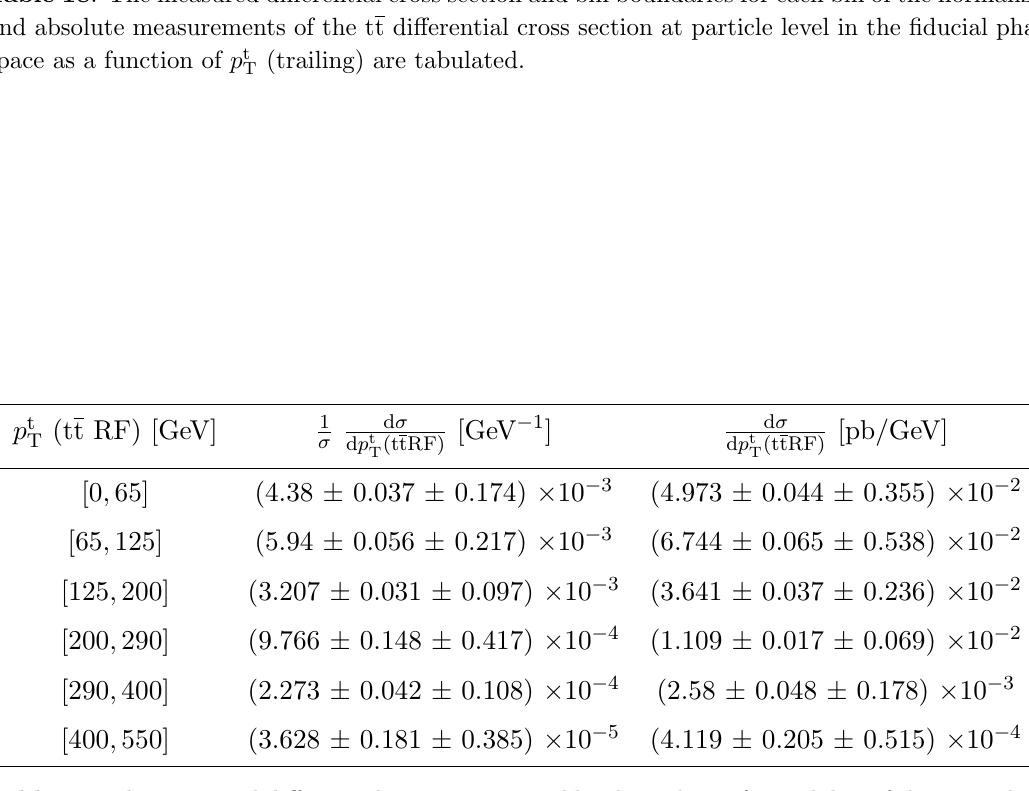
Table 19 . The measured di(cid:11)erential cross section and bin boundaries for each bin of the normalized and absolute measurements of the tt di(cid:11)erential cross section at particle level in the (cid:12)ducial phase space as a function of p t (tt RF) are T